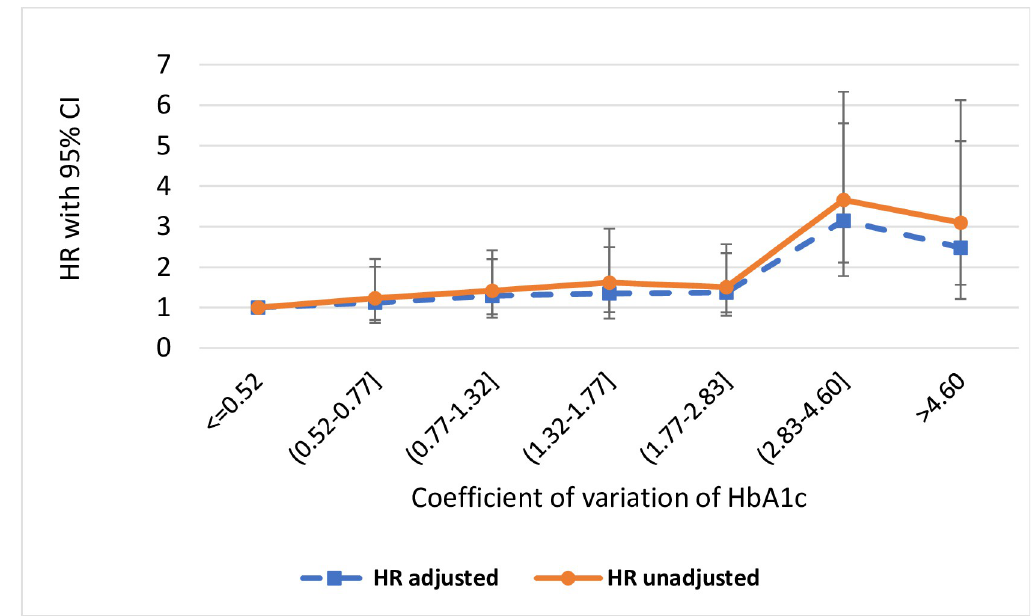
Fig 2. Hazard ratio (HR) of all-cause mortality according to variability of HbA1c levels. The association between HbA1c variability and the risk of all-cause mortality. Hazard ratios (HR) and 95% confidence intervals (CI) based on univariate and multivariate model are